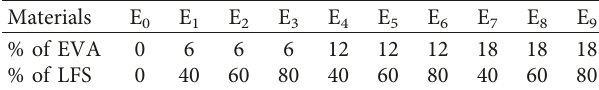
Table 6: Notations used for various blended mixes.